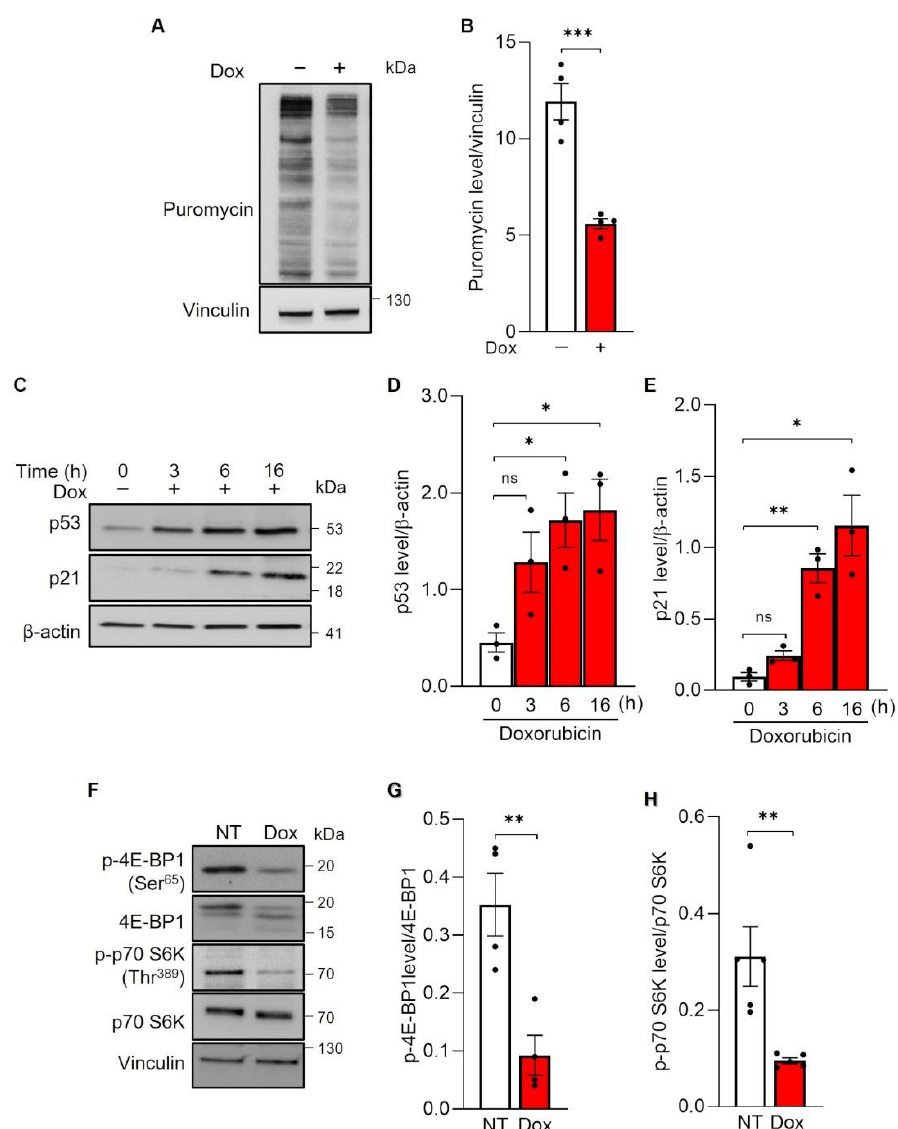
Figure 4. Global protein synthesis and mTOR activity during Doxorubicin treatment. ( A , B ) HUVECs were incubated (+), red histogram, or not ( − ), white histogram, with 250 nM Doxorubicin (Dox) for 16 h and then labelled for 10 min with of 90 µM Puromycin. Cells were lysed and analyzed by immunoblotting using an antibody against Puromycin. ( A ) Representatives immunoblot. ( B ) Quantification of puromycin levels by densitometric analysis. Data are shown as mean ± SEM of puromycin levels normalized to vinculin. n = 4 independent experiments per condition. *** p < 0.001 by unpaired Student’s t test. ( C – E ) HUVECs were incubated with 250 nM Doxorubicin and samples were collected at the indicated time during the treatment, red histogram. White histogram represents not-treated cells. ( C ) Representative immunoblot of HUVEC lysates analyzed using indicates antibodies. ( D , E ) Quantification of p53 and p21 protein levels, respectively, by densitometric analysis. Data are shown as mean ± SEM of protein levels normalized to β -actin, n = 3 independent experiments per condition. ns p > 0.05, * p < 0.05, ** p < 0.01 by unpaired Student’s t test. ( F – H ) HUVECs were treated (Dox, red histogram) or not (NT, white histogram) with 250 nM Doxorubicin for 16 h and analyzed by immunoblotting with the indicated antibodies for mTORC1 signaling. ( F ) Representative immunoblot. ( G , H ) Quantification of p-4E-BP1 (Ser 65 and total) and p-p70 S6K (Thr 389 and total), respectively, by densitometric analysis. Data are shown as mean ± SEM of phosphorylated protein levels normalized to total protein level. n = 4 independent experiments per condition. ** p < 0.01 by unpaired Student’s t test.